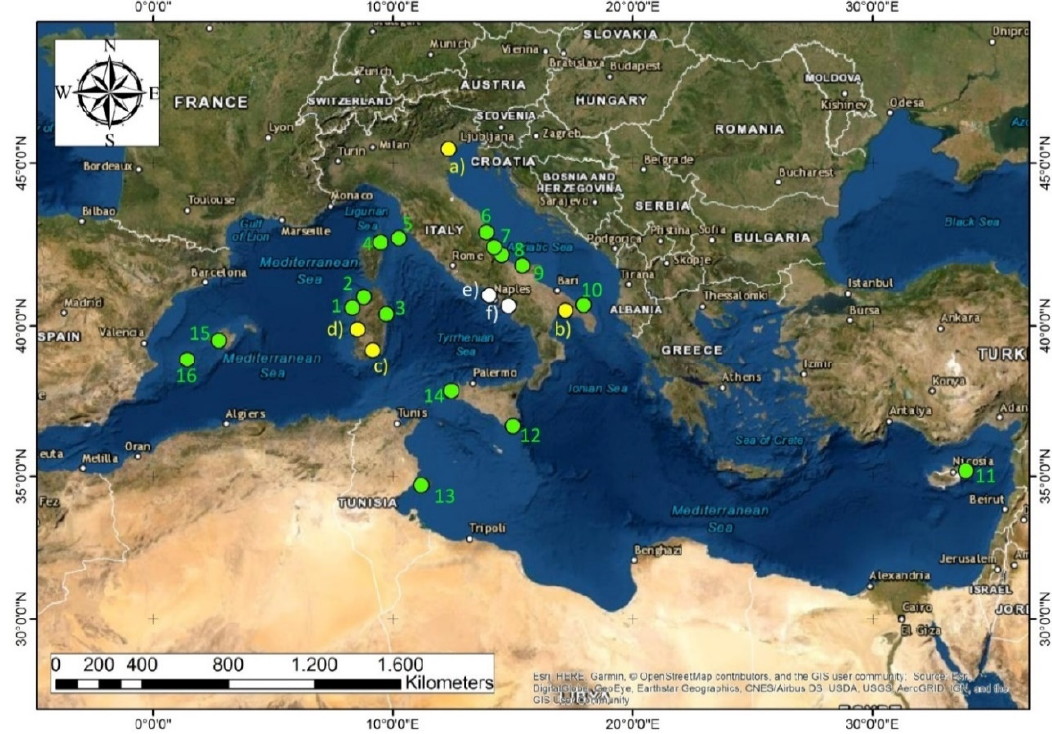
Figure 1. The Mediterranean coastal plains investigated in this paper (green dots) and previous studies by Antonioli et al. [29], Marsico et al. [30] (yellow marks and letters), Aucelli et al. [31,32] and Giordano et al. [33] (white marks and letters).